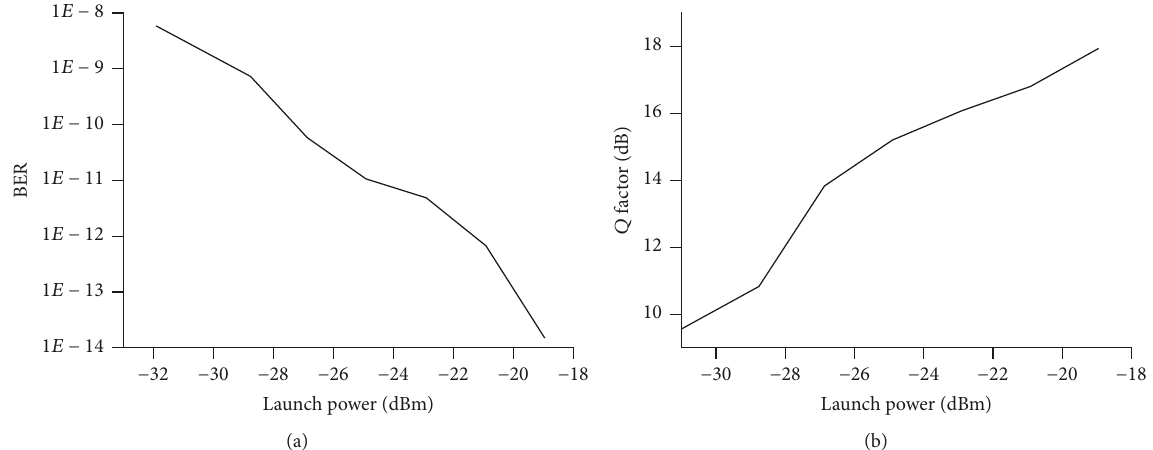
in comparison to the direct modulated one. The